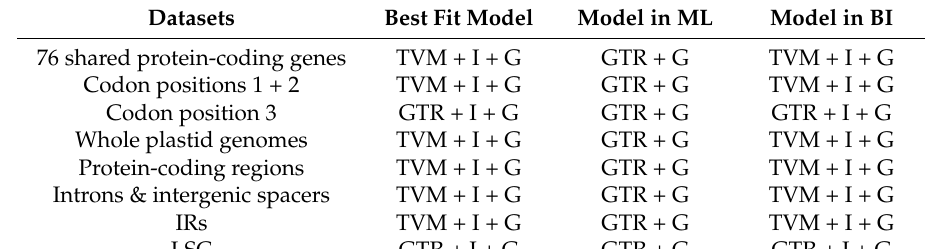
Table 2. Datasets and selected model in ML and BI analysis